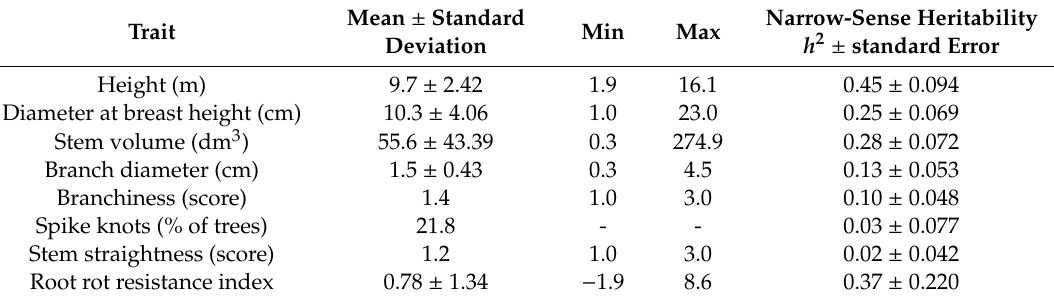
Table 1. Mean, minimum (Min), and maximum (Max) values and narrow-sense heritability indices of the studied traits.